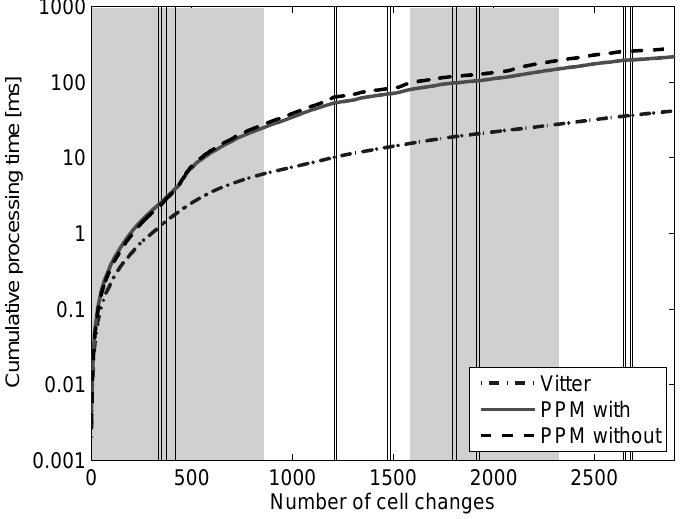
Figure 8. Accumulated processing time needed by Active LeZi updating scheme combined with each probability calculation method (log